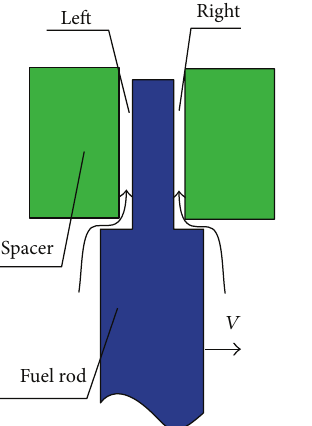
Figure 18: Diagram to explain the mechanism associated with leakage-flow-induced